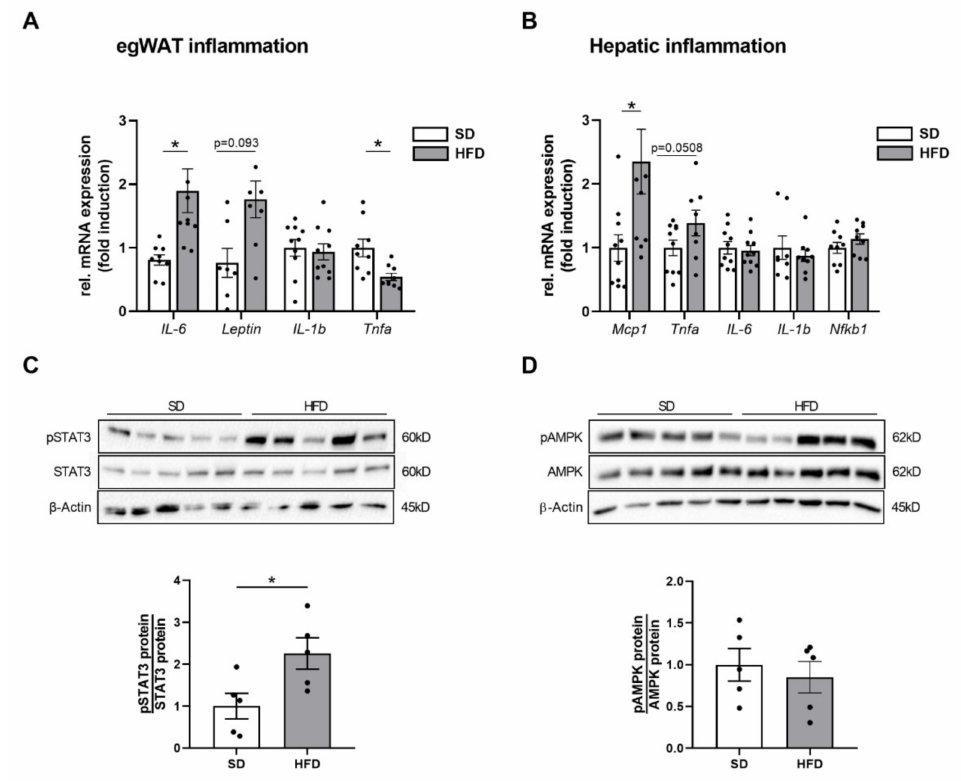
Figure 4. Perinatal obesity increases gene expression of inflammatory cytokines in egWAT and activates hepatic STAT3 signaling. ( A,B ) Assessment of the expression of genes encoding for inflam- matory cytokines and chemokines at postnatal day (P) 21 using quantitative real-time PCR: egWAT ( Il6 , Lep , Tnfa , Il1b (n = 10 per group), A ) and liver ( Mcp1 , Tnfa , Il6 , Nfkb1 (n = 10 per group), B ). ( C ) Phosphorylated and total STAT3 ( D ) as well as phosphorylated and total AMPK protein expres- sion were assessed by immunoblot; densitometric summary data show pSTAT3 and pAMPK relative to total STAT3 and AMPK, respectively. Densitometric analyses are displayed below the respective immunoblots. Immunoblots: SD group (n = 5), HFD group (n = 5). β -Actin served as loading control. Data are presented as mean ± SEM; * p < 0.05. AMPK, adenosine monophosphate-activated protein kinase; HFD, high-fat diet; Il6, interleukin 6; Il1b, interleukin 1b; Lep, leptin; Mcp1, monocyte chemoattractant protein 1; Nfkb1, Nuclear factor kappa B subunit 1; SD, standard diet; STAT3, signal transducer and activator of transcription 3; Tnfa, tumor necrosis factor